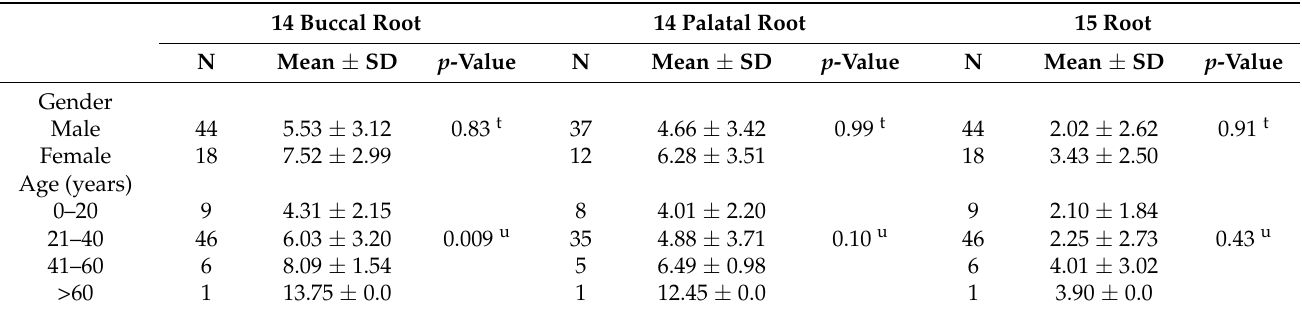
Table 3. Measurements of distances (mm) between apices of right premolar roots and floor of the maxillary sinus concerning age and gender ( n =